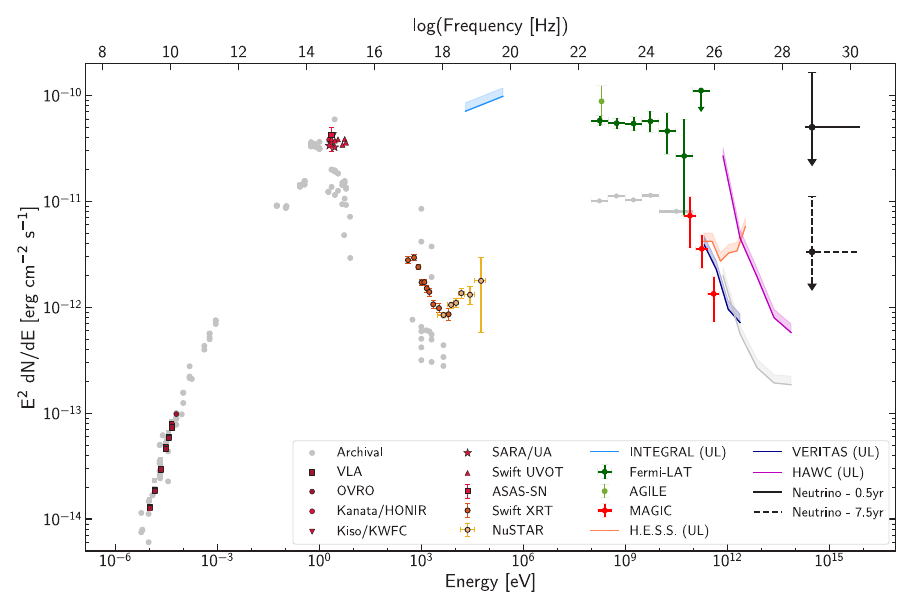
Figure 3. Spectral energy distribution based on observations obtained within 14 days of the detection of IceCube-170922A. 95% di ff erential flux upper limits are shown as colored bands and indicated as "UL" in the legend. Significant detections are shown by colored markers. Archival observations are shown in gray to illustrate the historical flux level of the blazar. Representative ν µ + ¯ ν µ neutrino flux upper limits that produce on average one detected event like IceCube-170922A over a period of 0.5 (solid black line) and 7.5 years (dashed black line) are shown assuming an E − 2 spectrum at the most probable neutrino energy. Figure from